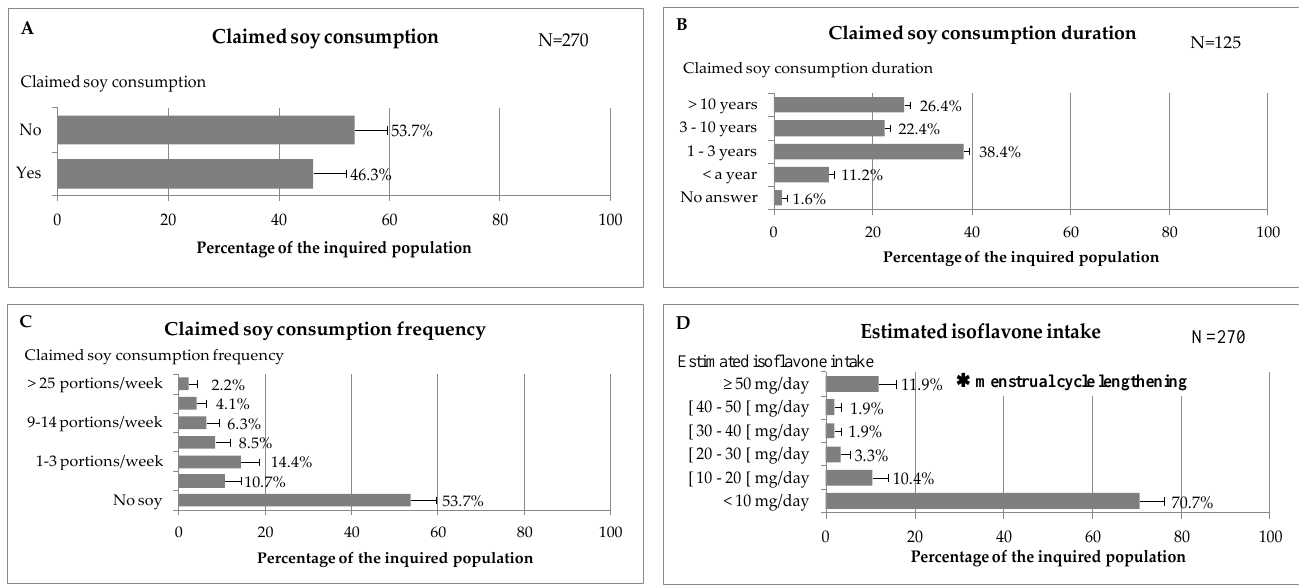
Figure 3. Main results of the survey performed on 270 premenopausal French women on their soy consumption. A . Percentage of premenopausal women consuming soy-based products or not. B . Duration of soy-based product consumption over women claiming regular soy intake. C . Frequency of soy intake from all the inquired population ( N = 270). D . Estimated isoflavone intake based on the isoflavone foodstuff estimation (Table S10a). Data are percentages and error bars are confidence intervals calculated with a risk error of 5%.